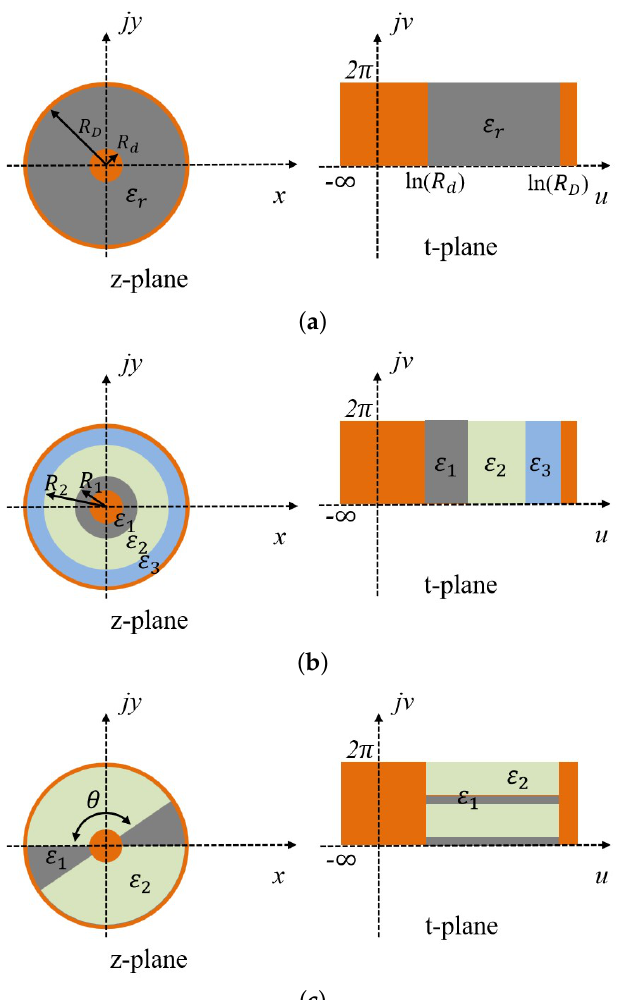
Figure 1. Schematics of the coaxial TSV in the z − plane and the transformed t − plane with ( a ) standard, ( b ) multi-layer, and ( c ) fan-shaped